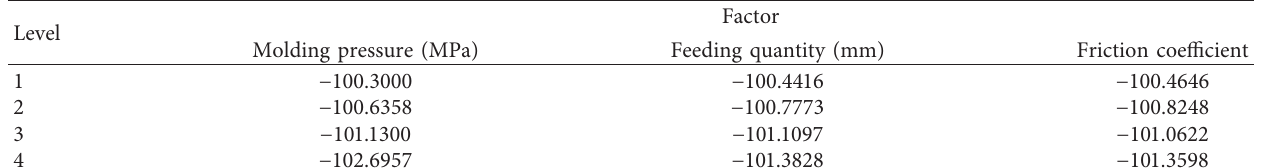
Table 11: SNR response table.